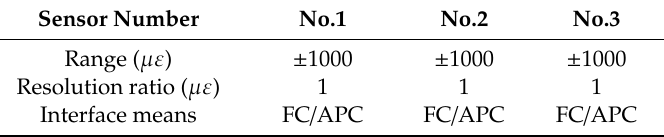
Figure 7. Photo of sensitized miniature FBG strain sensor. Table 2. Performance indexes of sensitized FBG strain